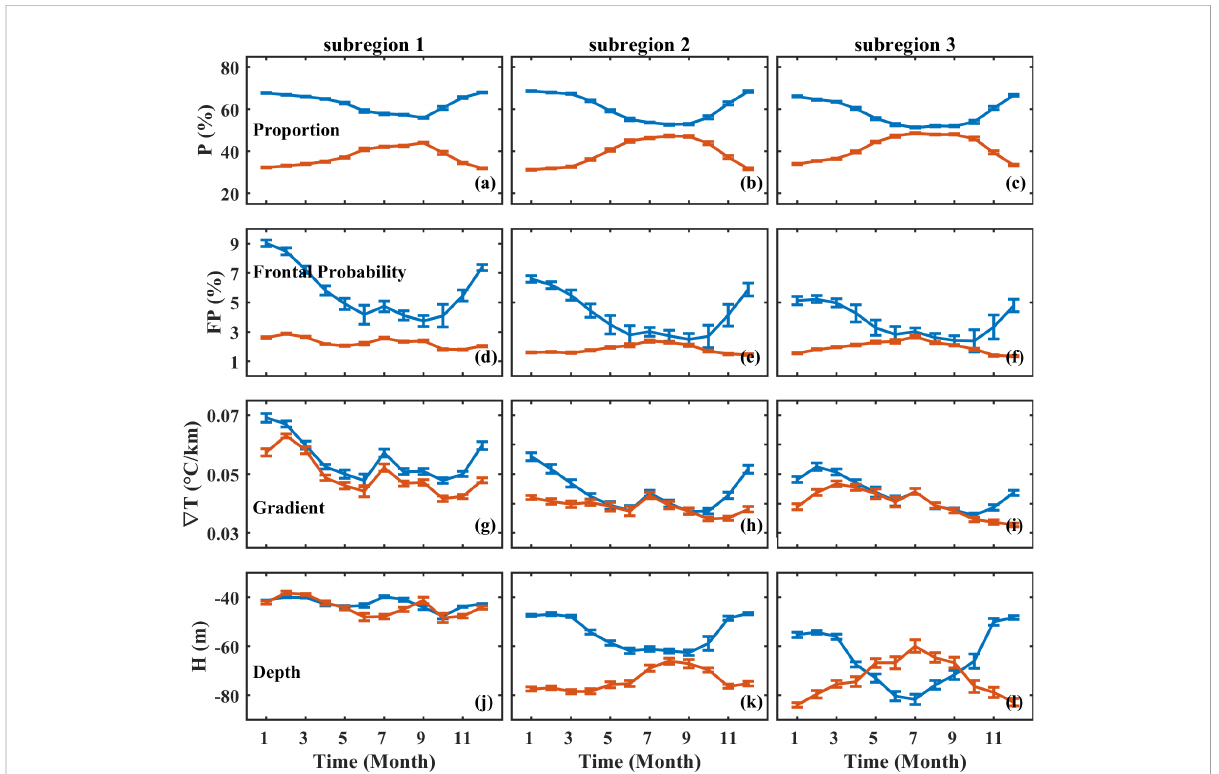
FIGURE 9 Mean monthly time series of cold and warm fronts in proportion (A – C) , frontal probability (D – F) , cross-frontal gradient (G – I) , and depth (J – L) at fronts for the three subregions averaged over 2002 − 2021. Blue (red) lines correspond to the cold (warm) fronts. The error bars denote the 95% con fi dence